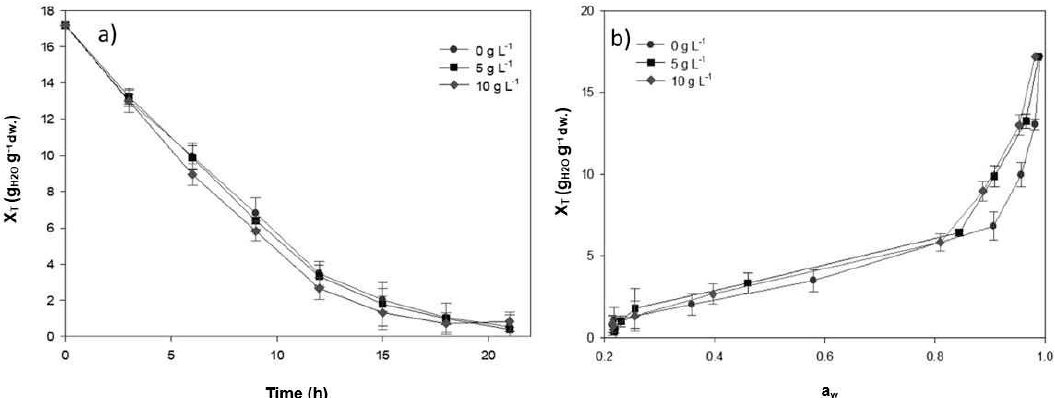
Fig. 3: Drying kinetics (a) and desorption isotherms (b) of nopal fl akes of O. fi cus-indica cv. Atlixco, preliminarily sweetened with three concentrations of rebaudioside A (0, 5, and 10 g L -1 ). Values represent the mean ± standard deviation of 3 replicates. Abbreviations: X t = equilibrium moisture content, a w = water activity, dw = dry Tab. 2: Sensory evaluation of nopal fl akes of O. fi cus-indica cv. Atlixco, sweetened with different concentrations of rebaudioside A.